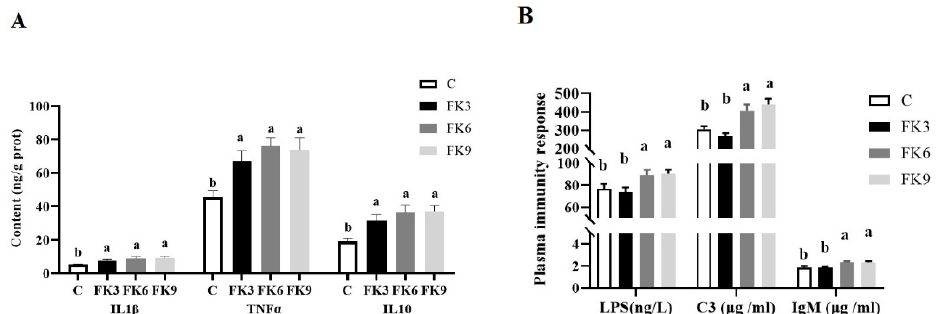
Figure 3. Inflammatory and immunity response of largemouth bass fed diets with various FK levels. ( A ) The intestine mucosal inflammatory cytokines contents; ( B ) Plasma LPS, C3 and IgM contents. Different superscript letters “a” or “b” indicate significant differences ( p < 0.05), whereas the same superscript letters show no significant differences among groups (means ± SEM, n = 12).